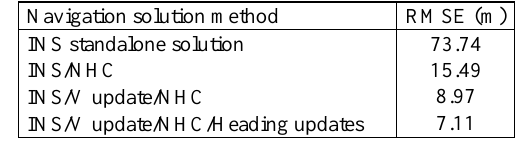
Table 2. The position RMSE for the second data set for 60 seconds GNSS signal outage for different updates and